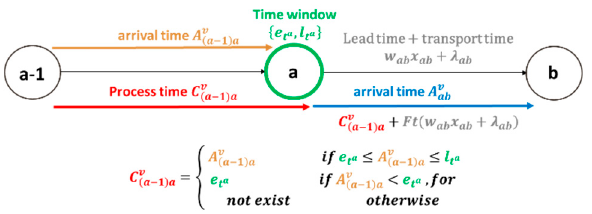
Figure 5. A graph of the time relationships of the time windows.